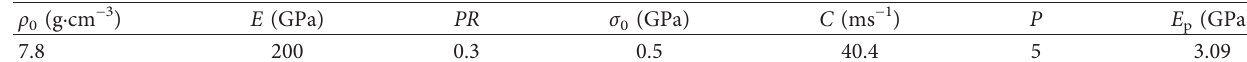
Table 3: Material parameters for steel fiber.